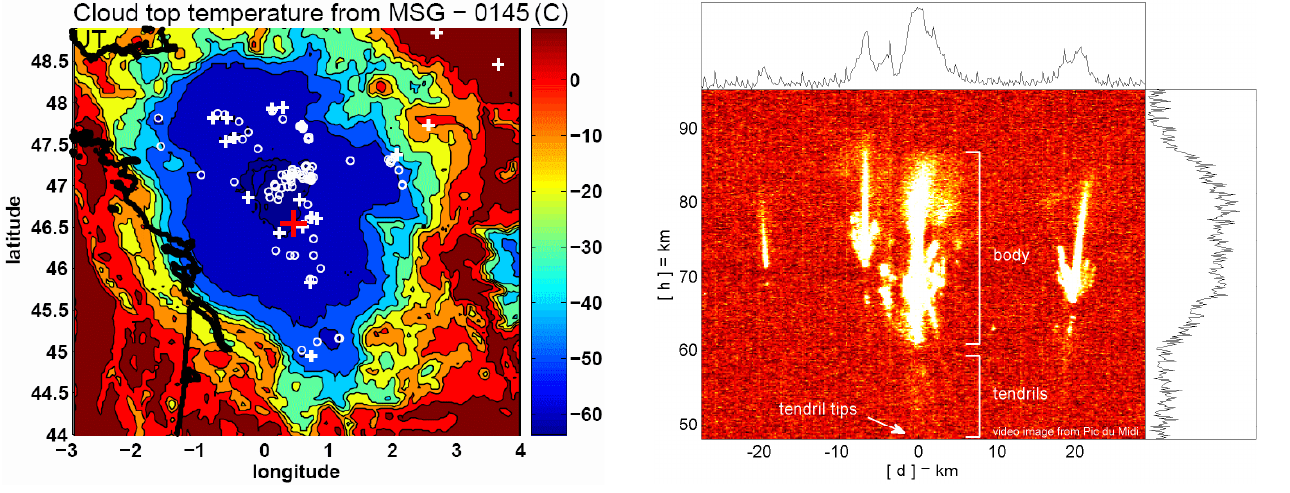
Fig. 1. A meso-scale convective system is located over France and reaches an area of ∼ 400 × 400km 2 at 01:45UTC on 31.08.2008 as inferred from the cloud top infrared brightness temperature. Many negative light- ning discharges (circles) cluster in the ∼ 12km ( T min = − 64C ◦ ) high convective core of the thunderstorm sur- rounded by some positive lightning discharges (crosses). One particular positive lightning discharge (red cross) at 01:52:59.524UTC causes a sprite discharge above the thundercloud. The size of the red cross indicates the area covered by individual sprite elements.